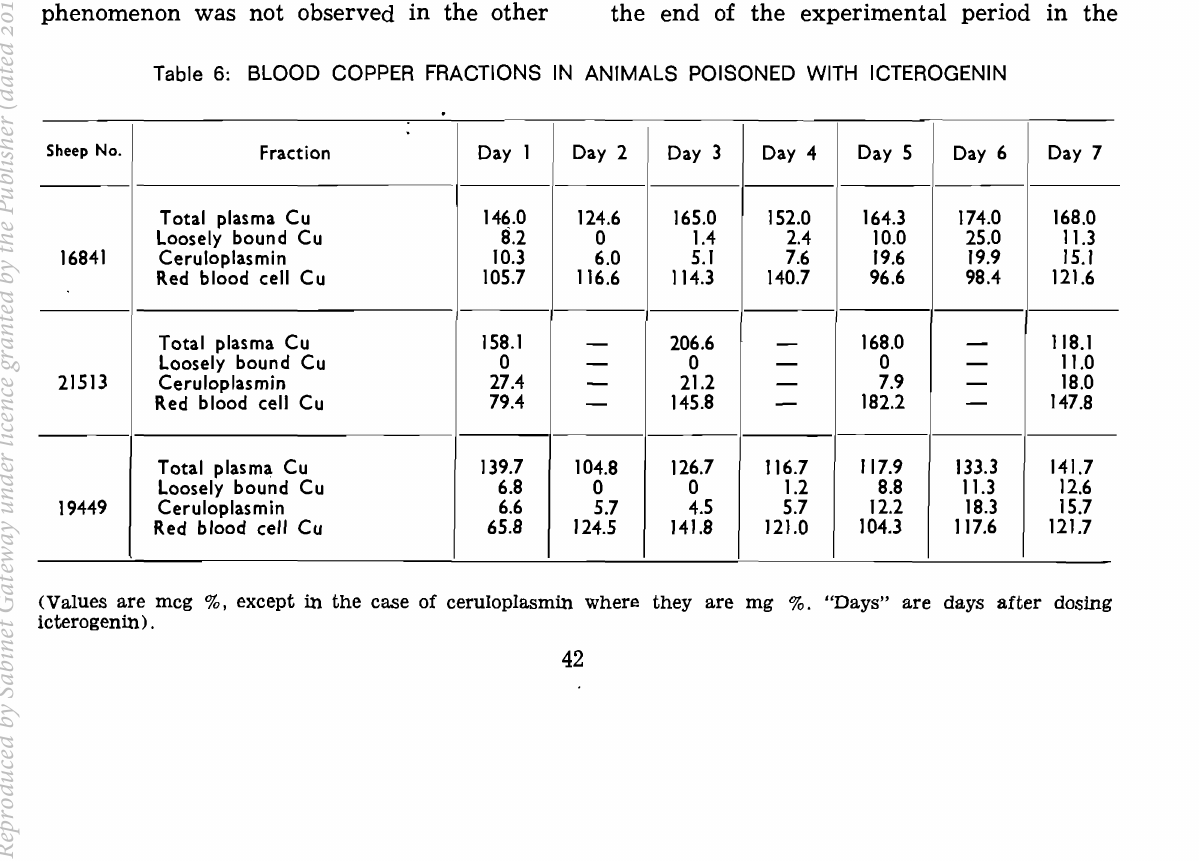
Table 6: BLOOD COPPER FRACTIONS IN ANIMALS POISONED WITH ICTEROGENIN